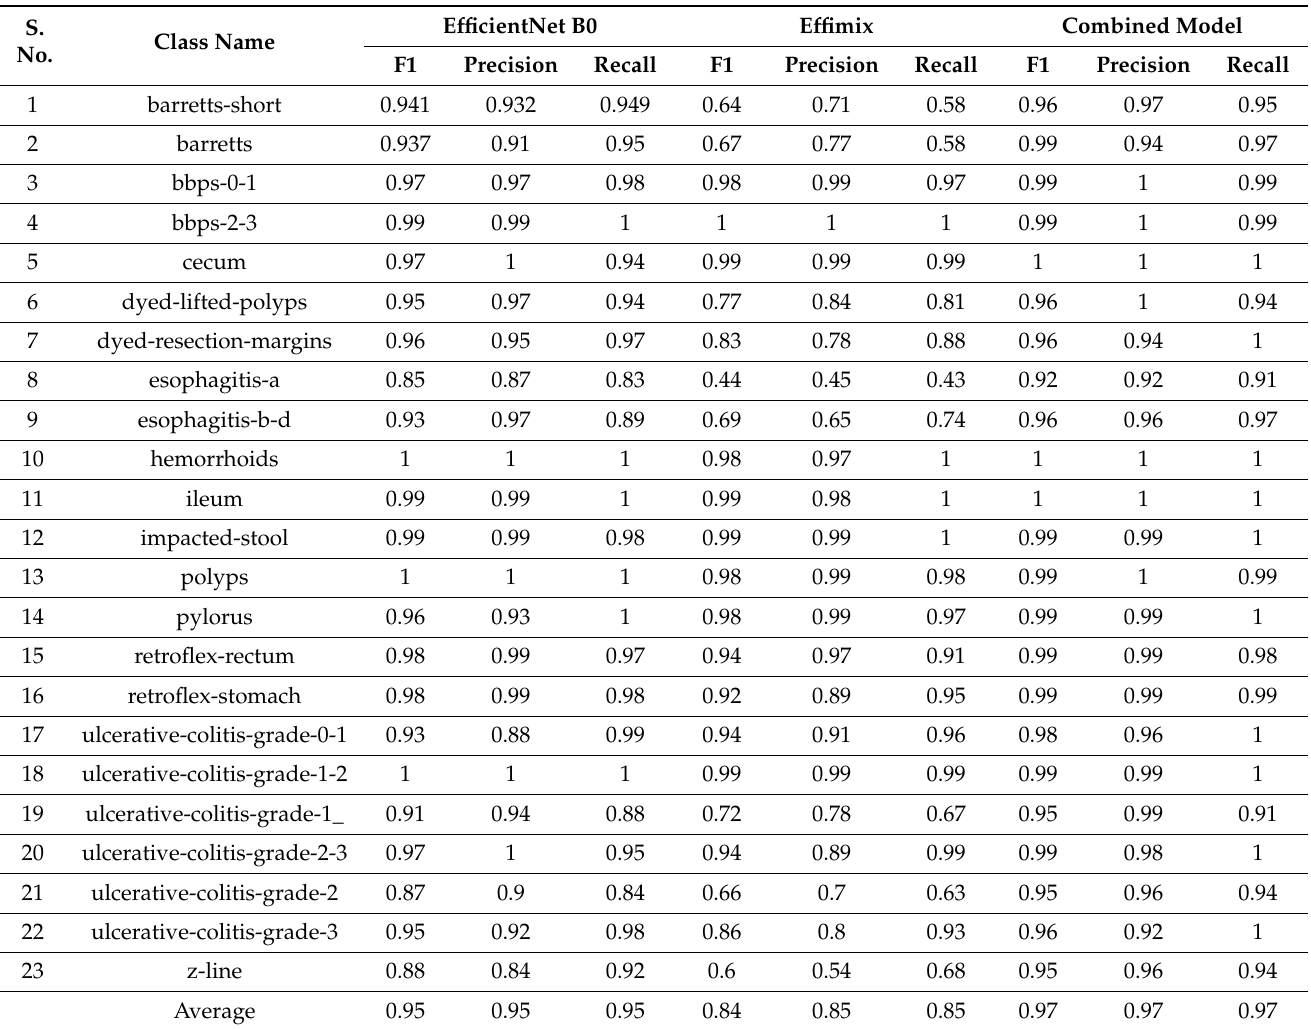
Table 3. Class-wise metrics of the proposed model.